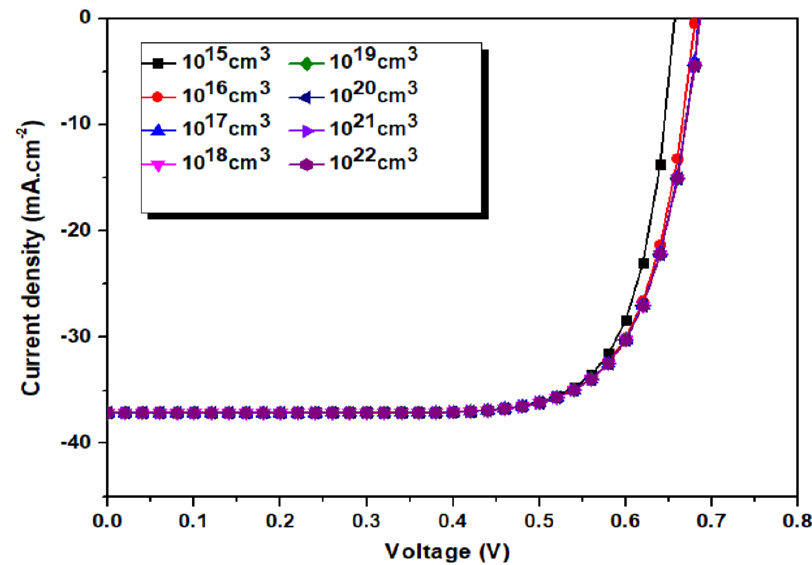
Figure 8. Effect of the doping concentration on the J – V curve of the bottom sub-cell.